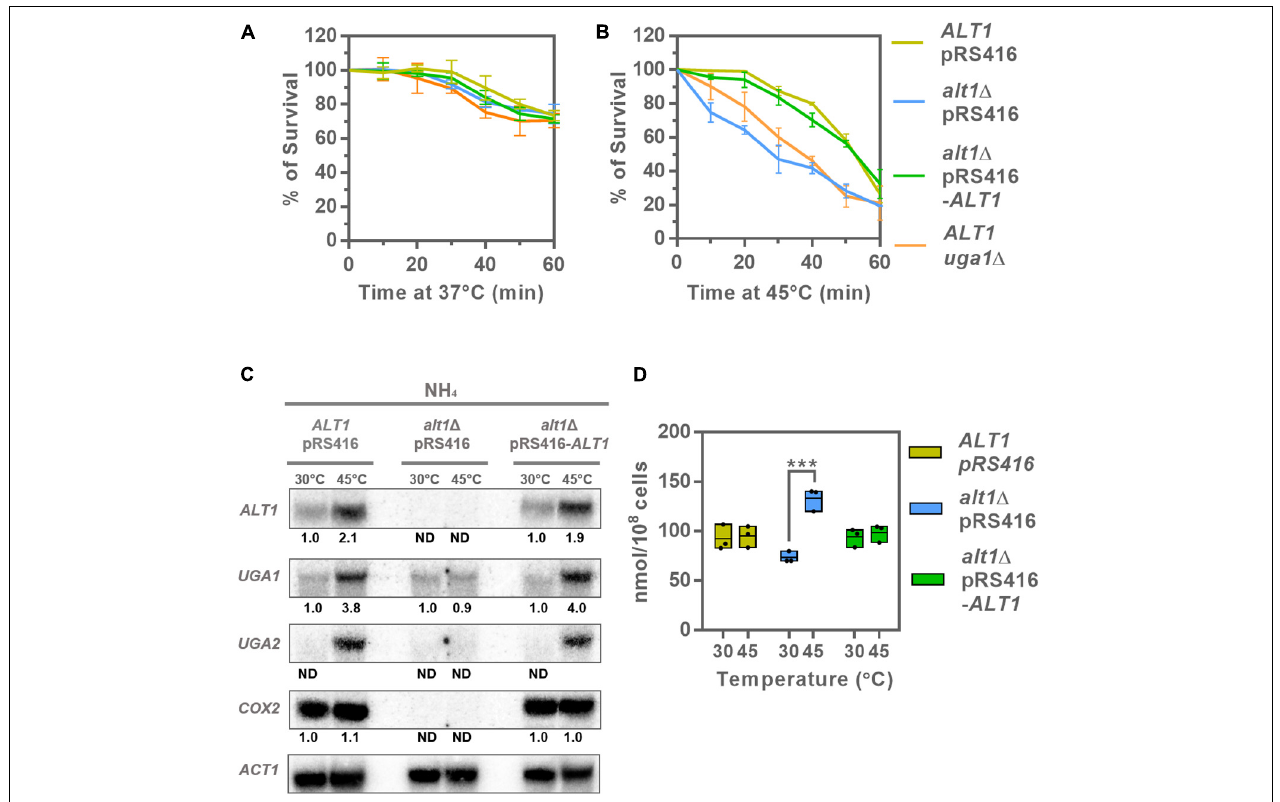
FIGURE 4 | GABA shunt and ALT1 expression is heat induced: alt1 (cid:49) and uga1 (cid:49) display heat sensitivity. Cellular viability, Northern blot, and alanine intracellular pools after heat stress treatment. (A) Determination of survival at 37 ◦ C from 0- to 60-min calculation of survival percentage was performed as described in section “Materials and Methods.” Data represent average ± SE of three independent experiments. (B) Determination of survival at 45 ◦ C from 0- to 60-min calculation of survival percentage was performed as described in section “Materials and Methods.” Data represent average ± SE of three independent experiments. (C) Northern blot to determine the expression of the GABA shunt genes at 30 and 45 ◦ C. Cells were cultured on glucose ammonium (NH 4 ) and harvested by centrifugation at OD 600 nm = 0.3 resuspended in glucose ammonium fresh medium, followed by a temperature treatment at 30 or 45 ◦ C for 20 min. Total RNA was prepared and used for Northern analysis as described in section “Materials and Methods.” Numbers below the blots represent the fold change with respect to the WT ALT1 pRS416 strain treated at 30 ◦ C (row 1) after quantification and normalization relative to ACT1 . (D) Alanine intracellular pools determined in extracts after a 20-min temperature treatment at 30 and 45 ◦ C in the ALT1 pRS416, alt1 (cid:49) pRS416, and alt1 (cid:49) pRS416- ALT1 strains. Boxes show individual values (points) and the average (middle line) ± SE of three independent experiments. Asterisks indicate significant difference [ ***P < 0.001, t -test (Student)]. Abbreviation: ND, not